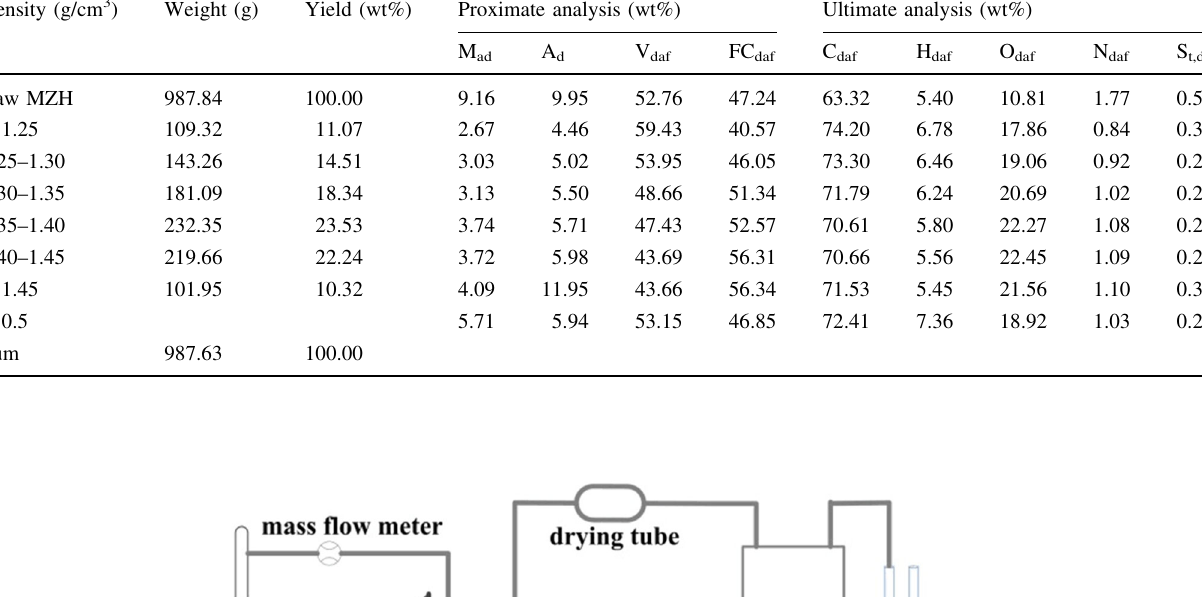
Table 1 Characteristics of coal in different densities by sink-and-float test Density (g/cm 3 )